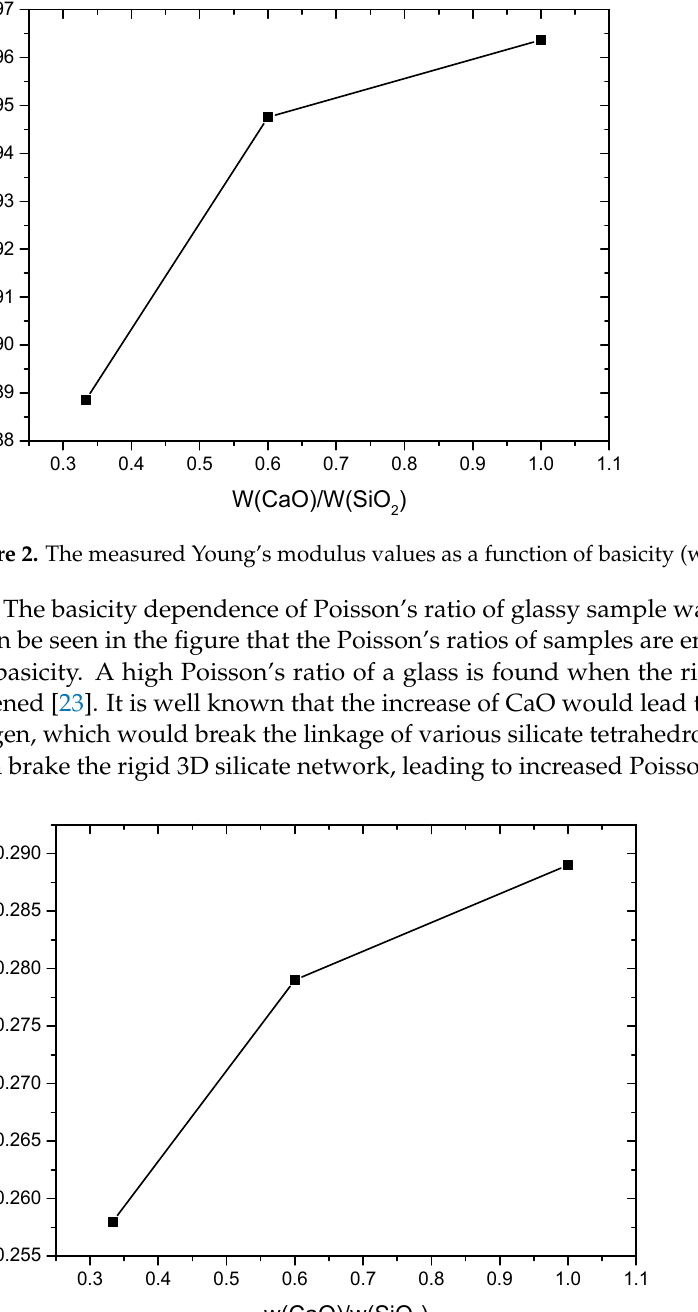
Figure 3. The measured Poisson’s ratios values as a function of basicity (w(CaO)/w(SiO 2 )). Sample no. 4 is mainly based on a CaO-Al 2 O 3 system with a minor SiO 2 addition. Both the Al 2 O 3 content and basicity are higher than in samples 1–4. This sample has the highest Young’s modulus value of all samples. Sample no. 5 has a similar Young’s modulus value with sample no. 1, for the contents of SiO 2 and Al 2 O 3 in sample no. 5 are the same as those in sample no. 1, However, the Poisson’s ratio of sample no. 5 is significantly lower than that of sample no. 1, indicating the type of ratio in aluminosilicate glass has some effects on Poisson’s